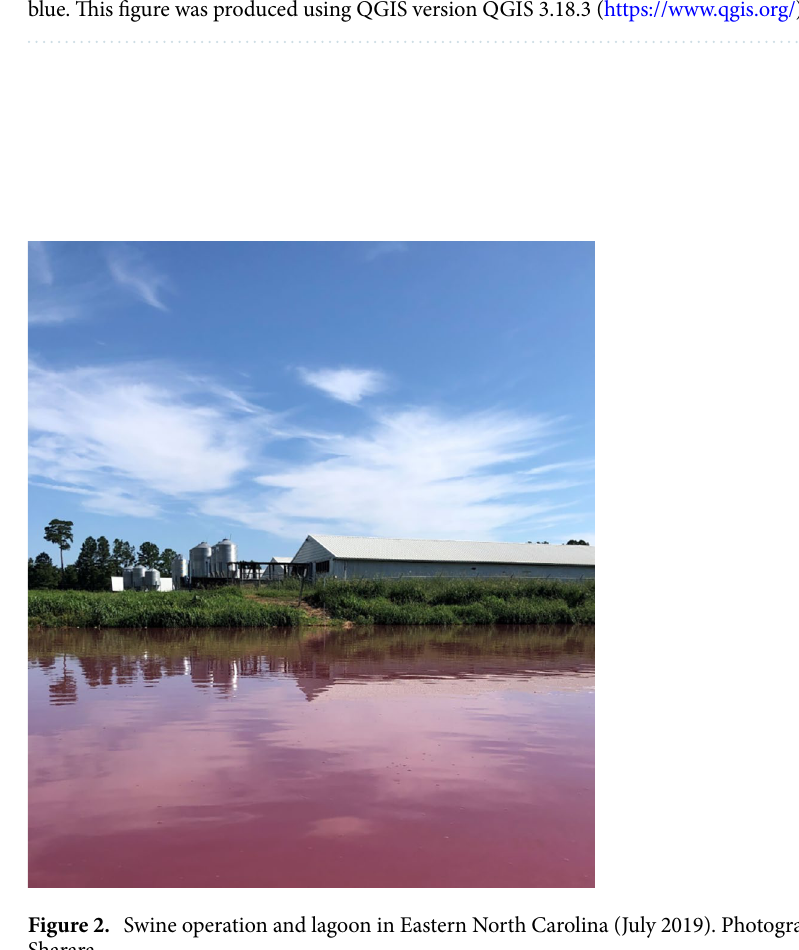
Figure 1. Study area, composed of the North Carolina (NC) Coastal Plain, USA. County boundaries are shown as gray lines, with the fill color corresponding to swine lagoon density (i.e., number of swine waste lagoons within the county). Watershed boundaries (HUC6) are shown with black lines, and labeled with numbers. The inset map in the bottom right shows the location of the study area (NC Coastal Plain) in the USA shaded in